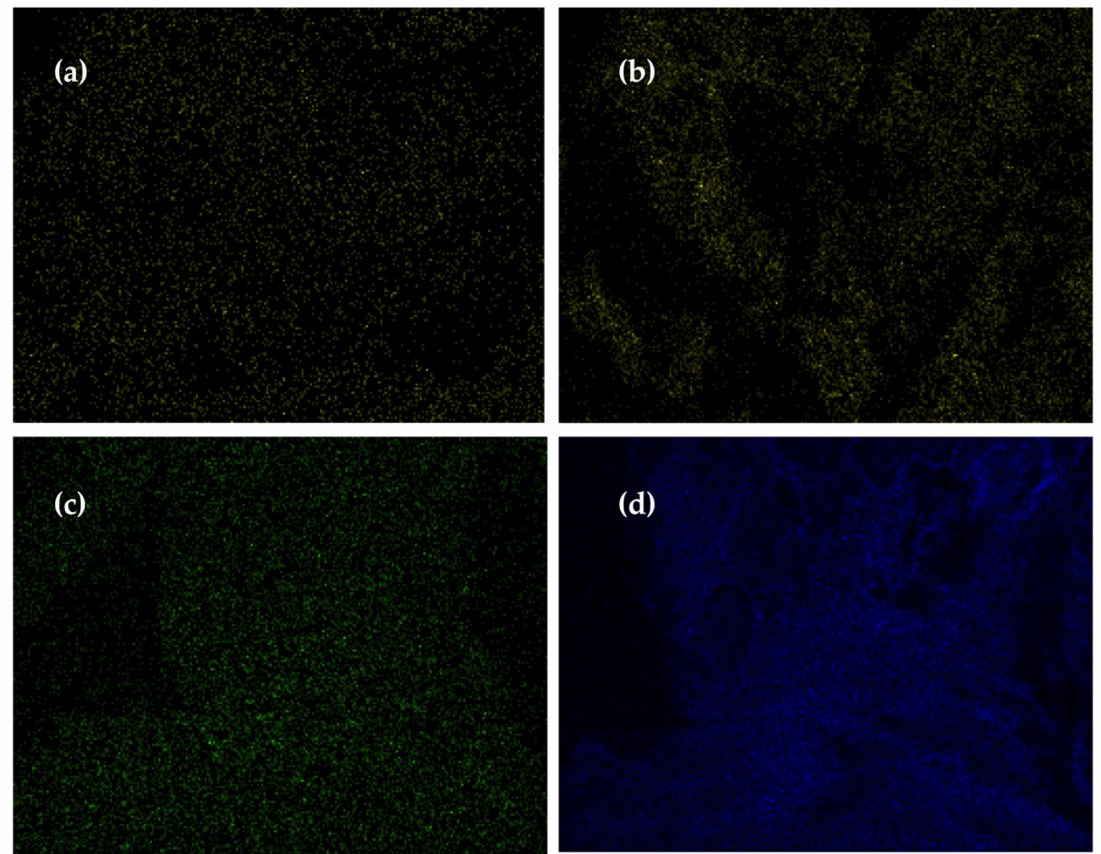
Figure 8. SEM / X-ray mapping of Lemna gibba loaded with Ni 2 + ( a ) and Zn 2 + ( b ) in single metal systems, and with Ni 2 + ( c ) and Zn 2 + ( d ) in binary metal